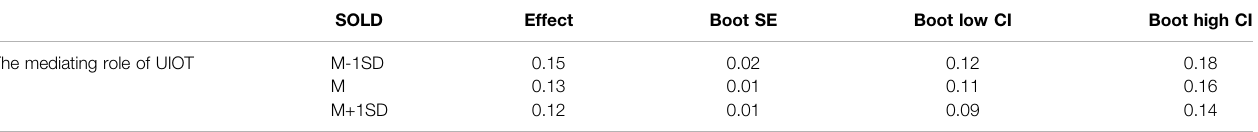
TABLE 4 | Moderated mediating effects of online learning dif fi